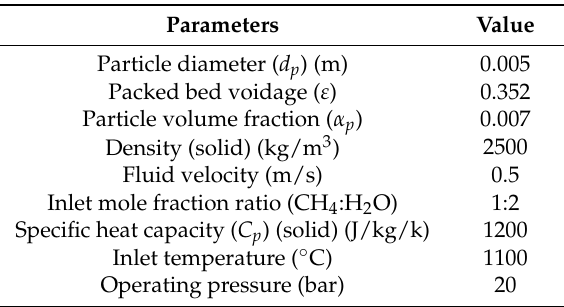
Table A1. Simulation parameters (PR-DNS) for steam methane reforming.